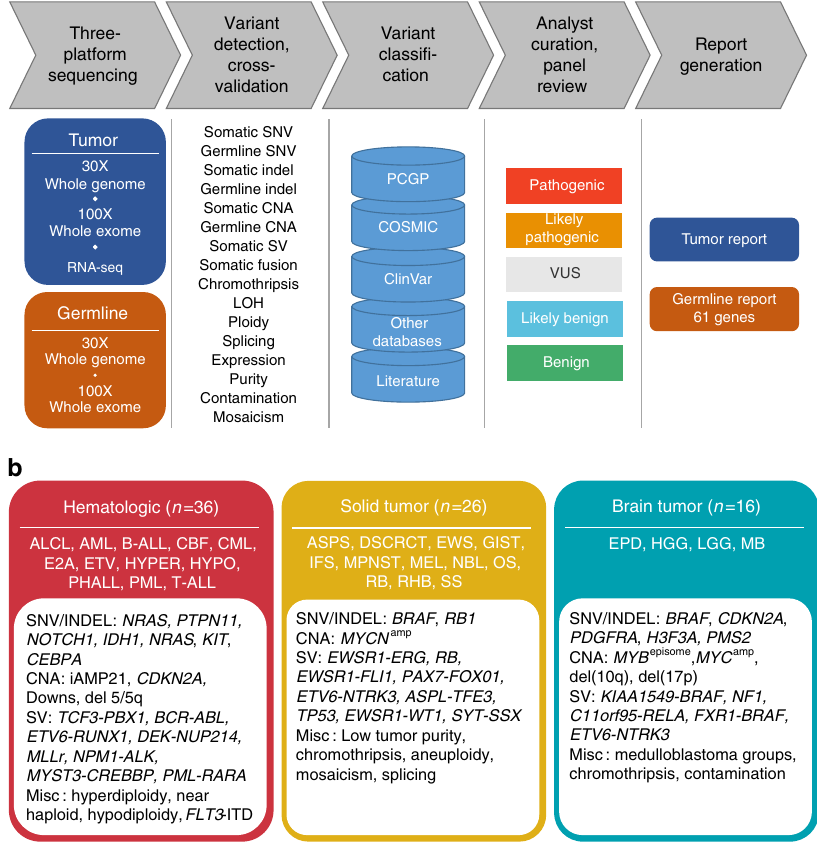
Fig. 1 Design of clinical three-platform sequencing. a Overview of sequencing, variant detection, variant classi fi cation, panel review and report generation. Chromothripsis was used as an annotation for ploidy report and we followed guidelines by Korbel and Campbell 59 . b Selection of 78 pediatric cancer patients with biomarkers identi fi ed by multiple molecular pathology